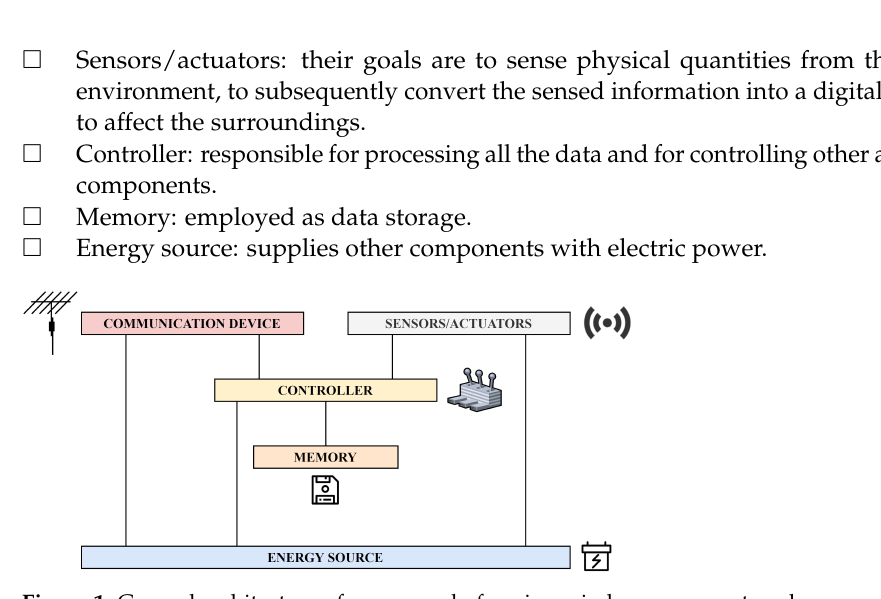
Figure 1. General architecture of sensor node-forming wireless sensor networks.